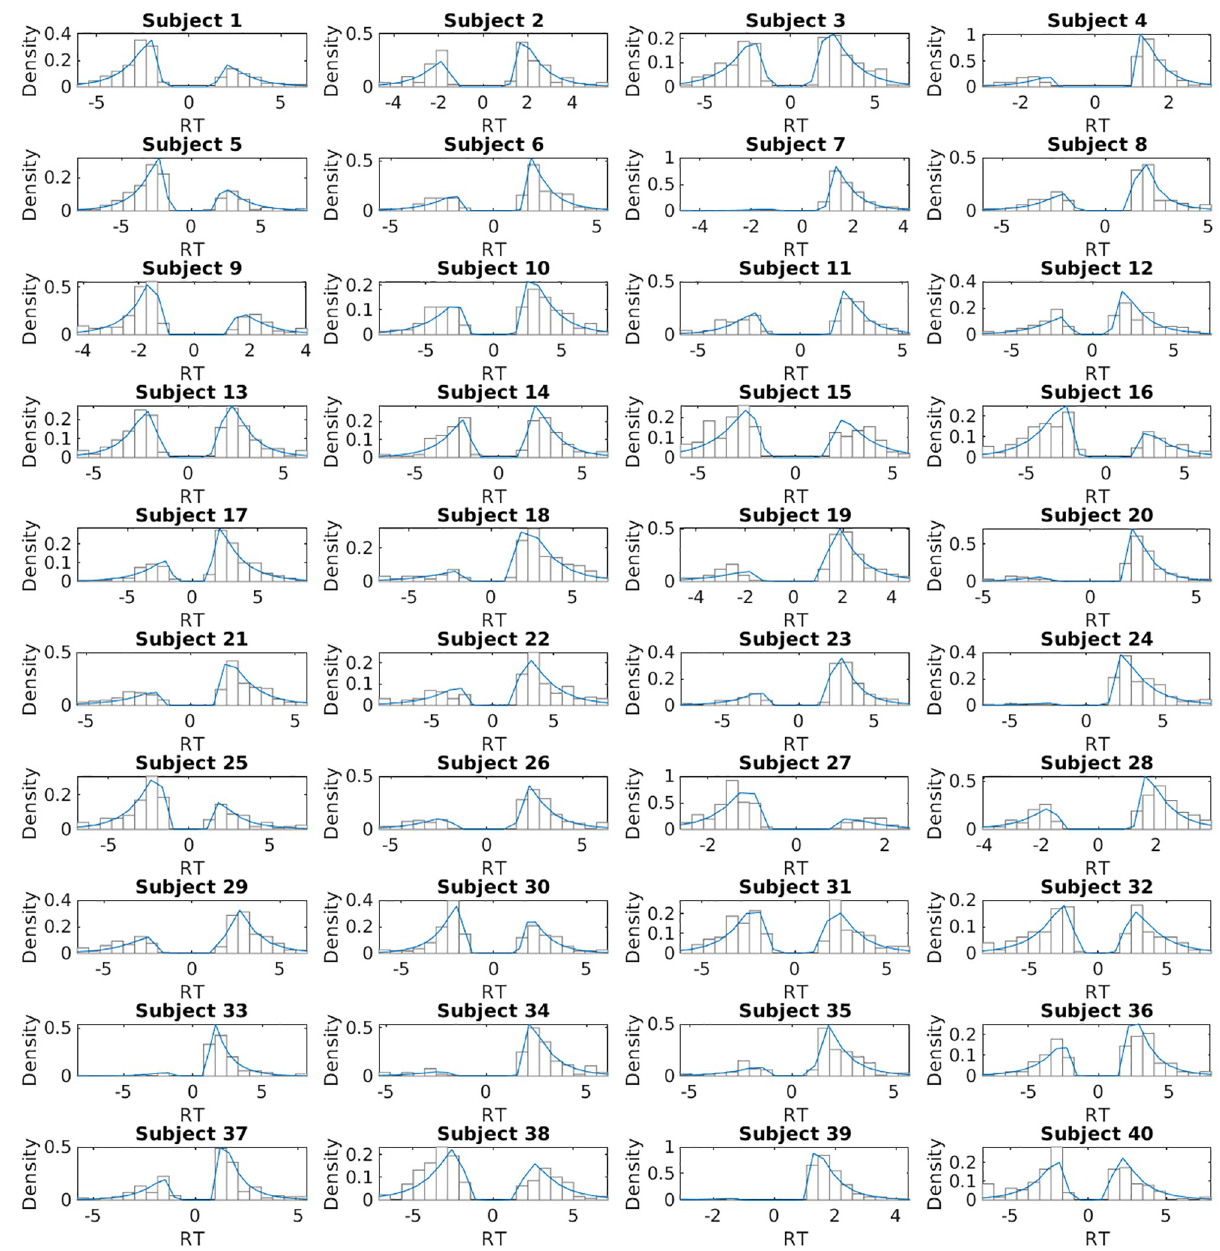
Fig 2. Posterior predictive response time distributions (in blue) of the DDM sig-shift (using normalised values) for each participant, overlaid on the histograms of the observed RT distributions. The negative response times arise from the boundary definitions of the DDM. We defined the lower boundary as choosing the SS reward, and the upper boundary as choosing the LL reward. For this purpose, choices towards the lower boundary were multiplied by -1. Negative response times indicate SS choices, positive response times indicate LL